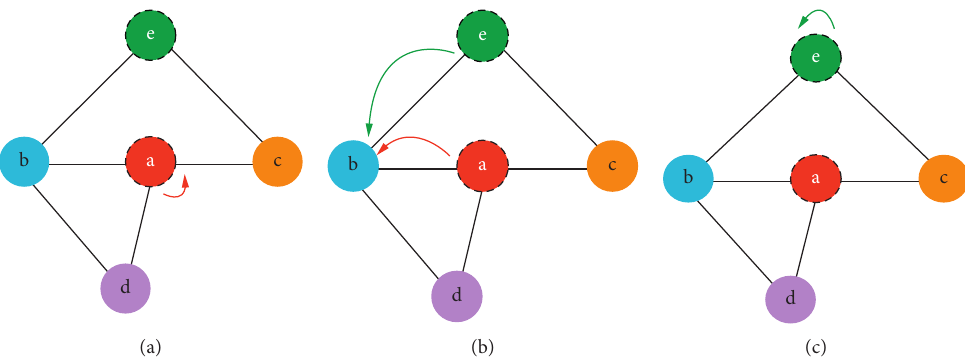
Figure 4: Convolution operation process in a batch of FastGCN under sampling distribution. (a) Sampling convolution operation of node A. (b) Sampling convolution operation of node B. (c) Sampling convolution operation of node E.